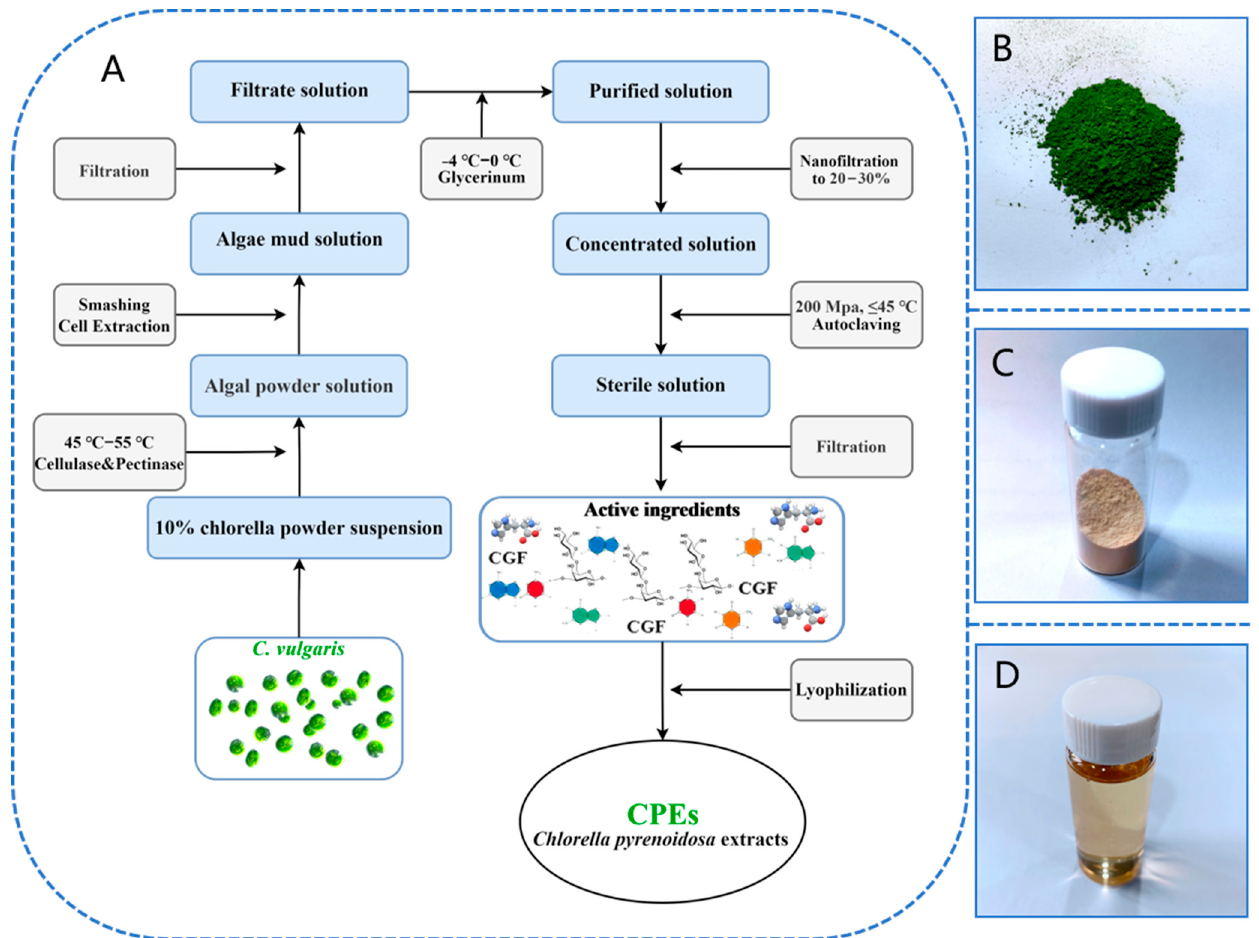
Figure 1. The extraction process of CPEs ( A ) and images of Chlorella pyrenoidosa ( B ) and its e x –tract ( C ) lyophilized powder; ( D ) aqueous solution. ( C ) lyophilized powder; ( D ) aqueous